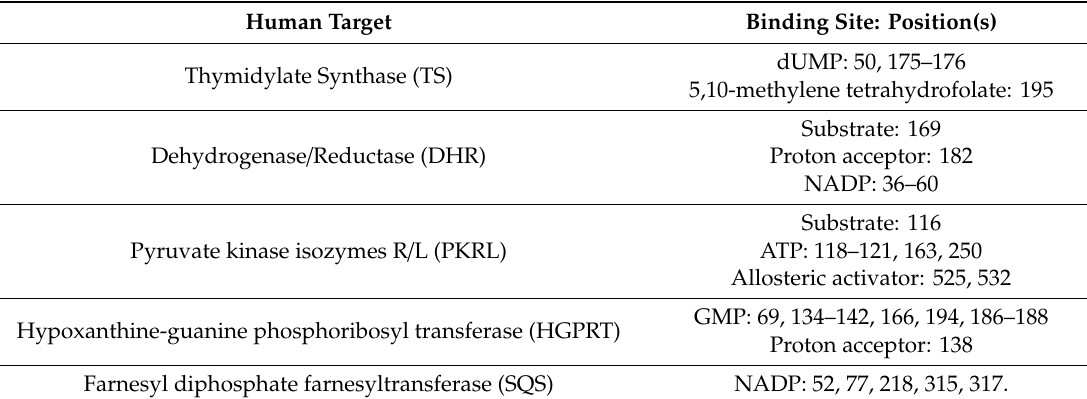
Table A4. Binding site positions retrieved from Uniprot